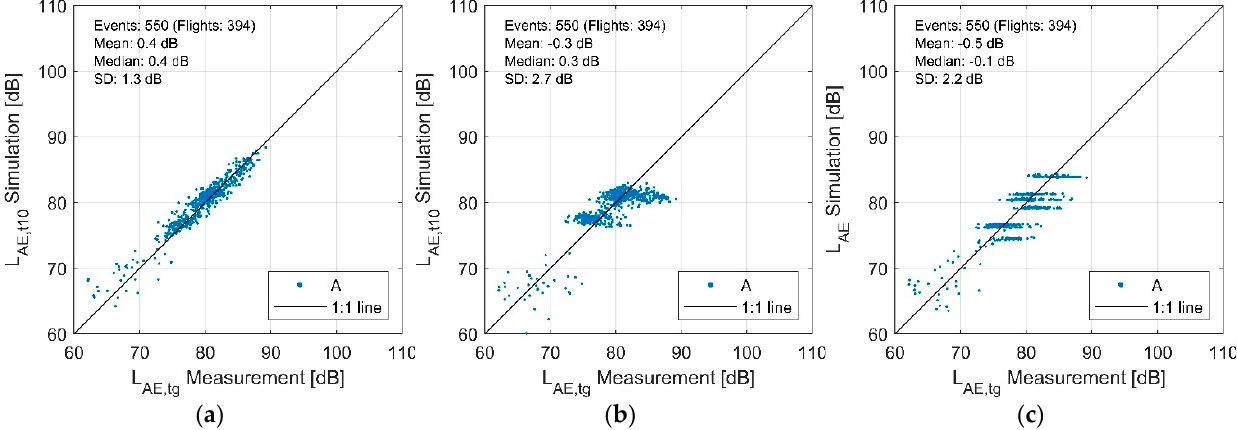
Figure 6. Scatter plots of simulation vs. measurements for approaches of aircraft with FDR data in the far range of ZRH. A: Approach, SD: Standard deviation. Note that no departures were recorded (Section 2.3). ( a ) sonAIR, ( b ) FLULA2, ( c ) AEDT.